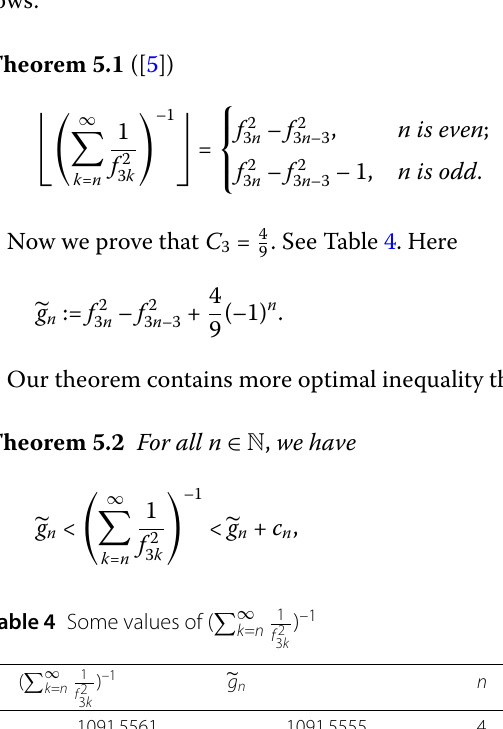
Table 4 Some values of (